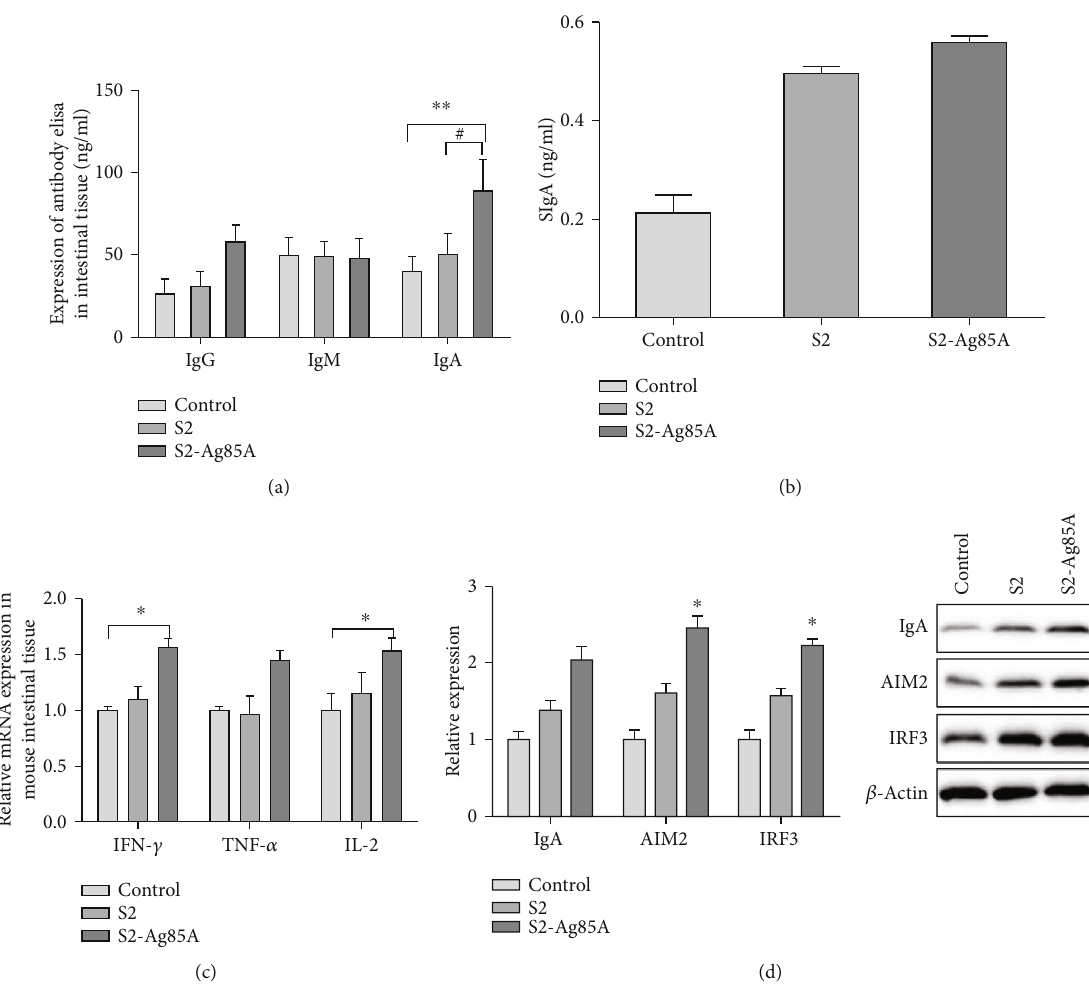
Figure 1: Oral S2-Ag85 vaccine increases the expression of IgG, IgM, and IgA in the gut of mice. (a) Oral S2-Ag85 vaccine increases the expression of IgG, IgM, and IgA in the gut of mice. (b) Content of IgG, IgM, and IgA in the intestine of mice in each group as determined by ELISA, compared with the control group. (c) Content of SIgA in the intestinal tissue of mice in the three groups. (d) Expression of IgA, AIM21, and IRF3 proteins in the intestinal tissue of mice in the three groups. ∗ P < 0 : 05 ; ∗∗ P = 0 : 01 ; compared with the S2 group # P < 0 : 05 ; ## P = 0 : 01